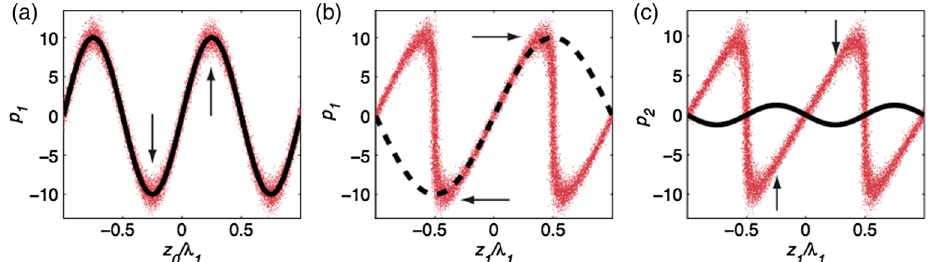
FIG. 3. Local linearization with a dispersive section between two modulations at the same wavelength, (cid:6) 1 . The beam is first modulated with amplitude A 1 (a), and then longitudinally dispersed by B 1 ¼ 1 =A 1 (b). This distributes particles in the region (cid:1) (cid:6) 1 = 2 < z 1 < (cid:6) 1 = 2 along a sinusoid with wavelength 2 (cid:6) 1 (dashed line). A subsequent smaller modulation A 2 shifted by (cid:1) (solid line), removes the curvature in the decompressed region